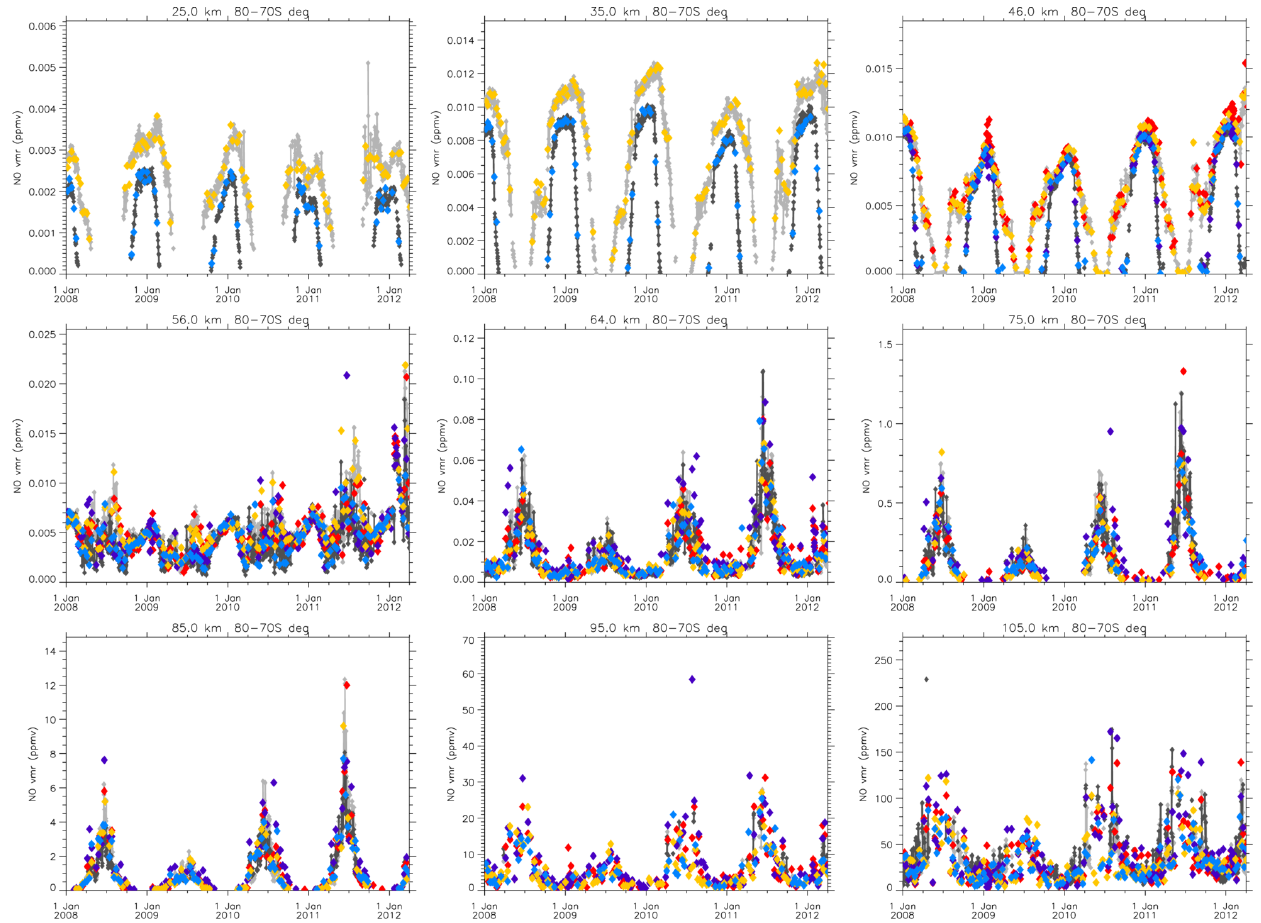
Figure 16. Time series of daily zonal mean NO vmrs at various altitudes (as indicated in the plot titles) from NOM RR (grey: morning, black: afternoon), MA (orange: morning, light blue: afternoon), and UA (red: morning, dark blue: afternoon) measurements during 2008–2012 at 70–80 ◦ S